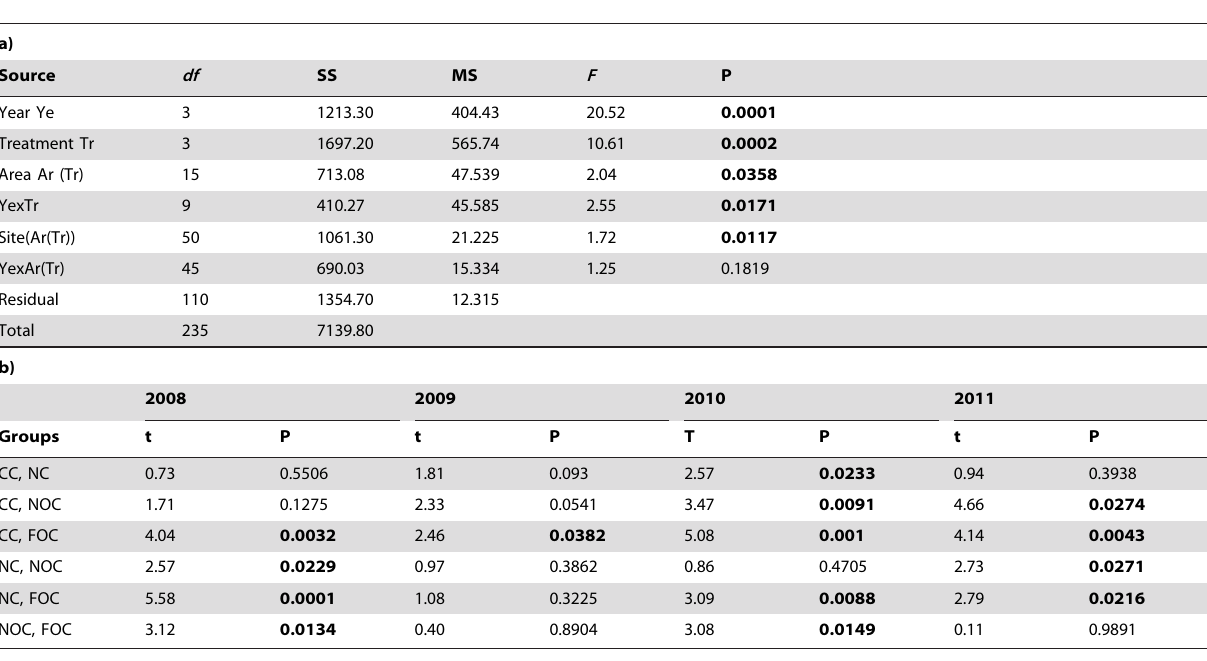
Table 1. PERMANOVA of species richness based on Euclidean distance